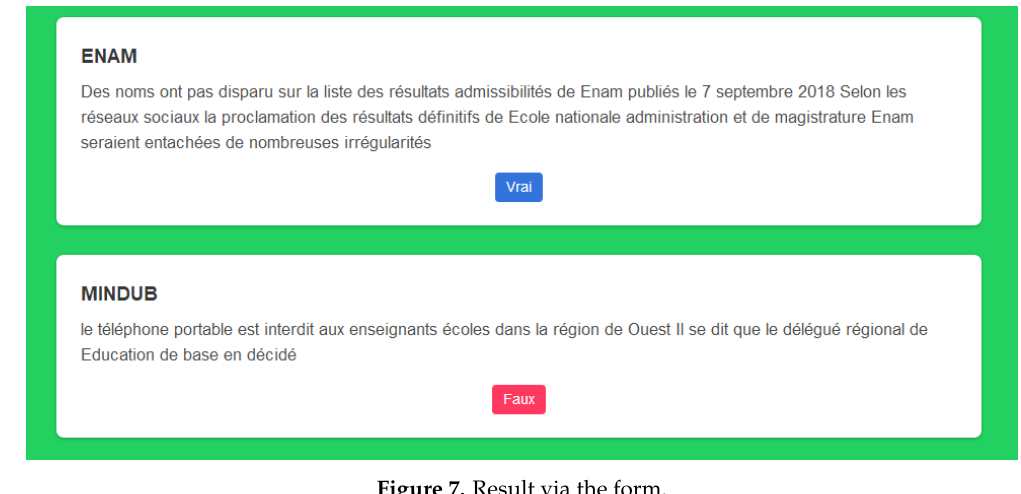
Figure 7. Result via the